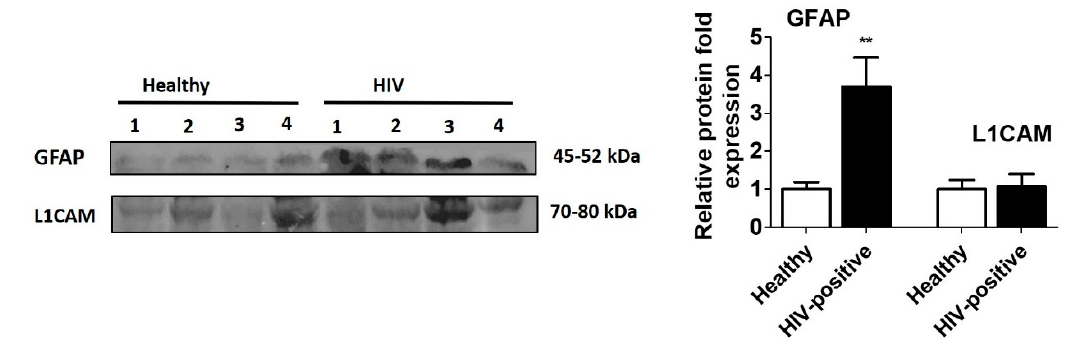
Figure 2. Expression of neuronal and astrocyte marker proteins in plasma EVs of Healthy and HIV-positive subjects. EVs were isolated from plasma of healthy ( n = 4) and HIV-positive subjects ( n = 4). Equal amounts of protein were loaded to analyze the expression of GFAP and L1CAM proteins in healthy as well as HIV-positive samples. GFAP expressions were found to be significantly high in HIV-positive subjects compared to healthy subjects, suggesting CNS damage in HIV-subjects. * indicates p < 0.05, considered significant.